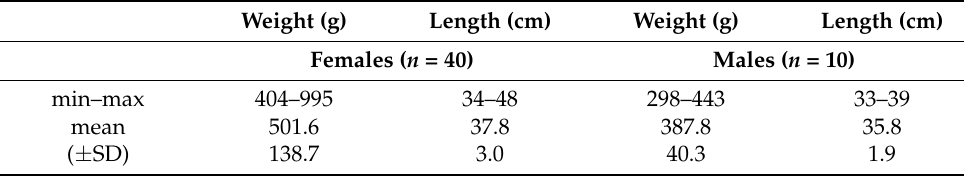
Table 1. Characteristics of the examined blue bream Ballerus ballerus (L.)